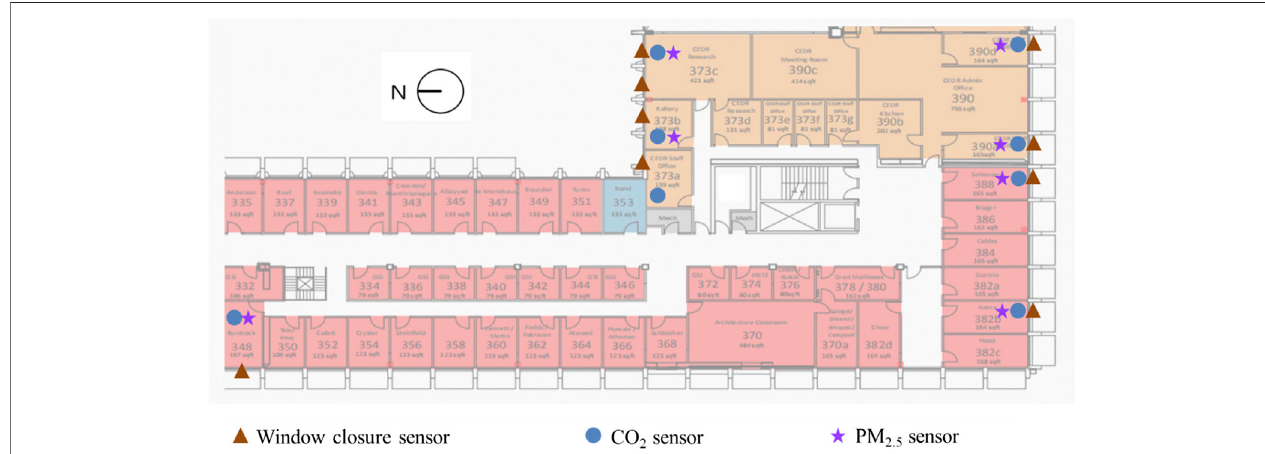
FIGURE 1 | The locations of the indoor sensors installed on the third fl oor. There are other indoor sensors on the fi rst and the second fl oors (see Table 1 for more information). The 9- fl oor case building is located in Berkeley, California, the United